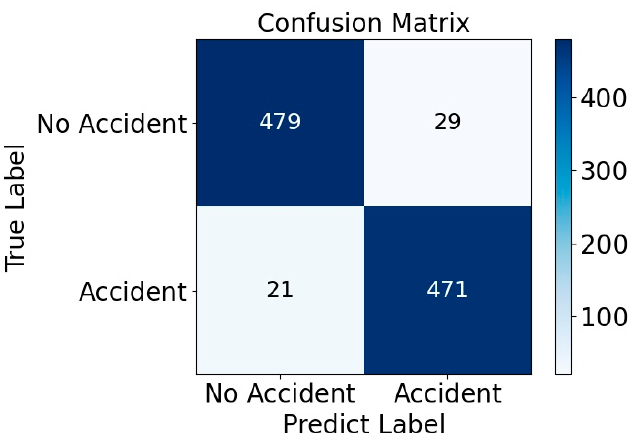
Figure 4. Confusion matrix for the proposed hybrid method. Table 3. Evaluation indicator results for traffic accident